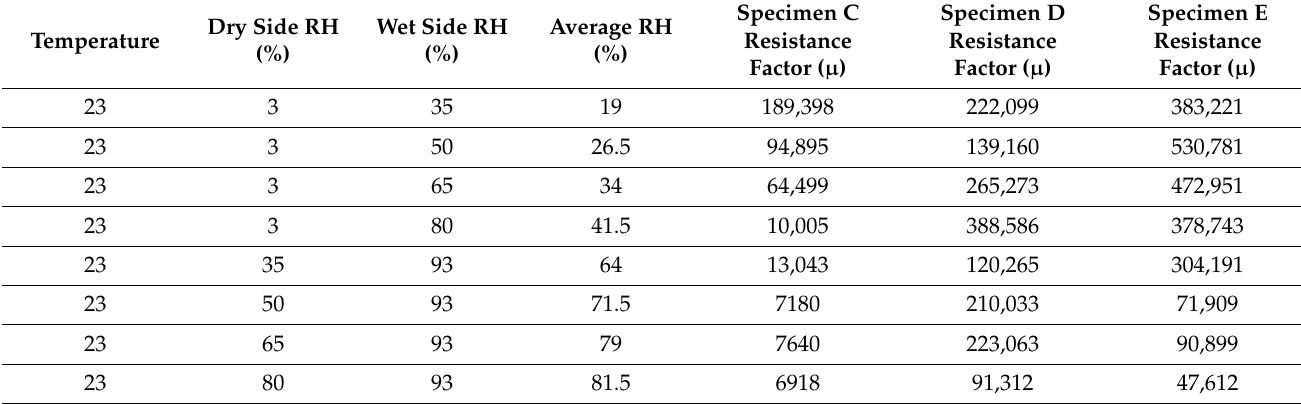
Table 4. Water vapour resistance factor with different boundary conditions.